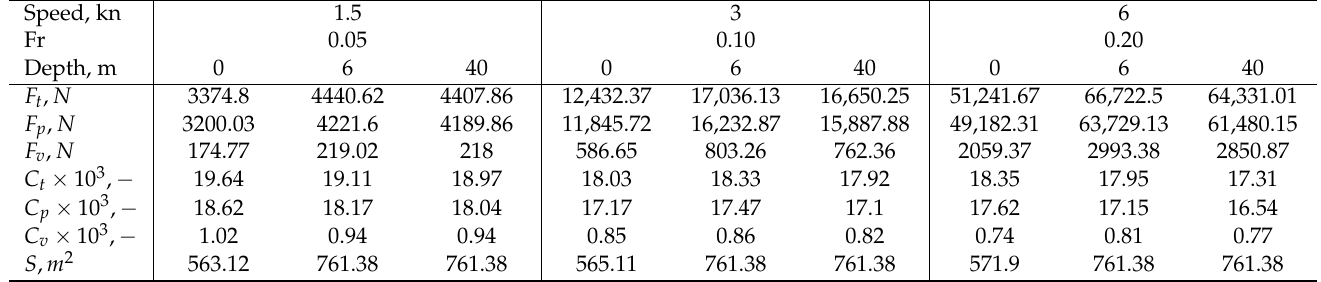
Figure 12. Resistance of individual patches of Geometry 3 when sailing at depth of 40 m. Table 3. Resistance results for the complete submarine geometry, Geometry 3.